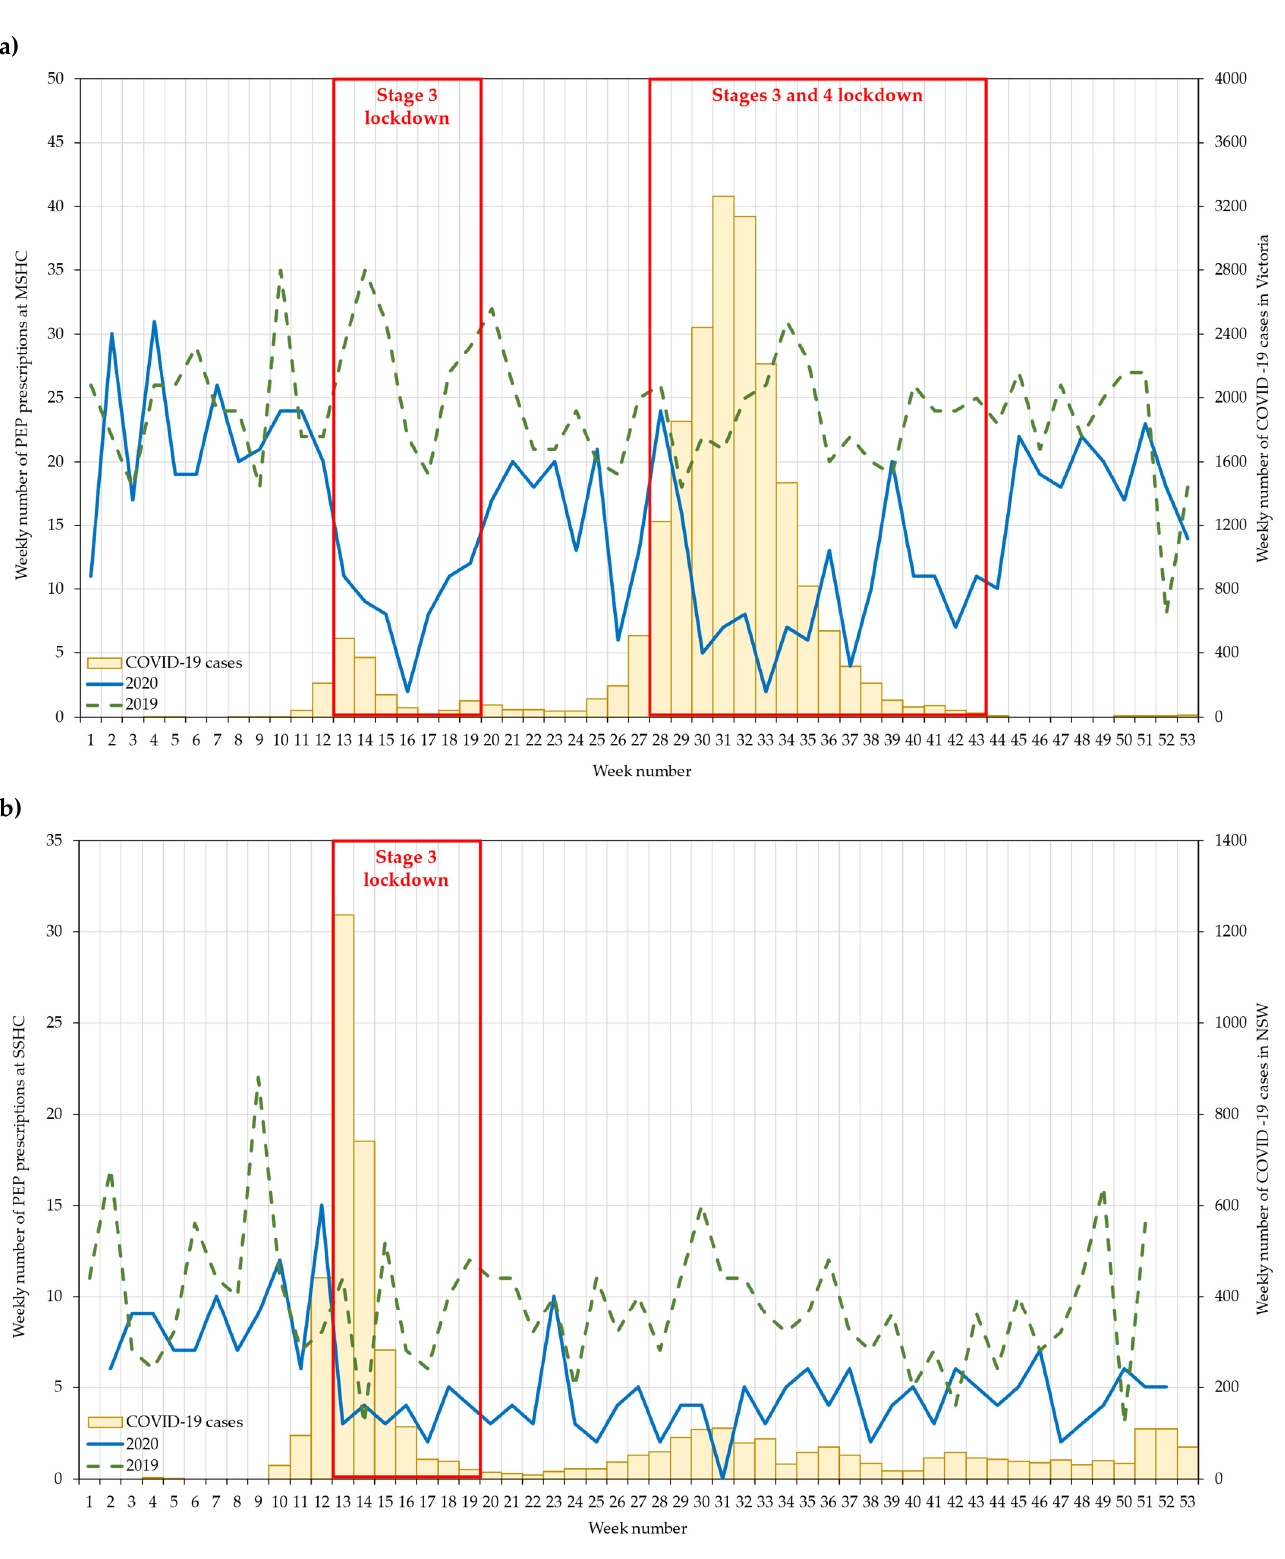
Figure 2. Weekly number of HIV post-exposure prophylaxis prescriptions at the ( a ) Melbourne Sexual Health Centre and ( b ) Sydney Sexual Health Centre, in 2019–2020. Data were not available in 2019 weeks 52 and 53, and 2020 weeks 1 and 53 at the Sydney Sexual Health Centre due to closure over Christmas and New Year. Stage 3 lockdown included social-distancing rules, stay-at-home orders, and closure of non-essential businesses. Stage 4 lockdown included Stage 3 lockdown measures in addition to a curfew (8 pm–5 am) and a 5 km travel limit.